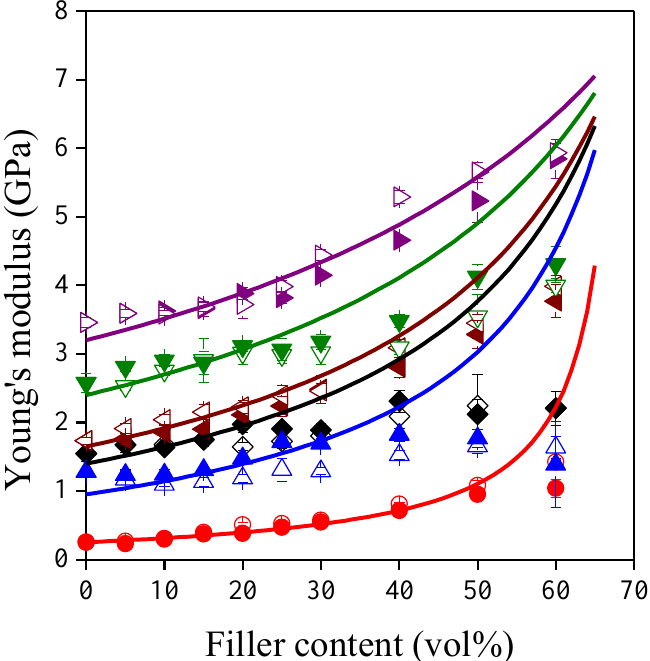
Figure 2. Estimated moduli as a function of observed moduli representing the goodness-of-fit for Figure 1. Effect of filler content on the stiffness of the composites. Symbols: ( Figure 1. Effect of filler content on the stiffness of the composites. Symbols: (  ) PP; (  ) LDPE; (  ) the Lewis–Nielsen model. Symbols: (  ) PP; (  ) LDPE; (  ) HDPE; (  ) PS; (  ) PETG; (  ) PLA; ) PP; ( ) LDPE; ( Figure 4. Effect of filler content on the strength of the composites.Symbols: (  ) PP; (  ) LDPE; (  ) Figure 9. Correlation between reversible work of adhesion and reinforcement in the composites Figure 8. Correlation between reinforcement and matrix strength in the composites studied. Sym- Figure 5. Effect of filler content on the brittleness of the composites. Symbols: (  ) PP; (  ) LDPE; Figure 1. Effect of filler content on the stiffness of the composites. Symbols: (  ) PP; (  ) LDPE; (  ) HDPE; (  ) PS; (  ) PETG; (  ) PLA; empty symbols: SP20; full symbols: SPF; Lewis–Nielsen model. HDPE; (  ) PS; (  ) PETG; (  ) PLA; empty symbols: SP20; full symbols: SPF. empty symbols: SP20; full symbols: SPF. studied.Symbols: (  ) PP; (  ) LDPE; (  ) HDPE; (  ) PS; (  ) PETG; (  ) PLA; empty symbols: SP20; bols: (  ) PP; (  ) LDPE; (  ) HDPE; (  ) PS; (  ) PETG; (  ) PLA; empty symbols: SP20; full symbols: (  ) HDPE; (  ) PS; (  ) PETG; (  ) PLA; empty symbols: SP20; full symbols: SPF. One trend line ) PS; ( HDPE; (  ) PS; (  ) PETG; (  ) PLA; empty symbols: SP20; full symbols: SPF; Lewis–Nielsen model. SPF. full symbols: represents the LDPE composites having the highest deformability, and the other one represents the much more rigid PLA composites.